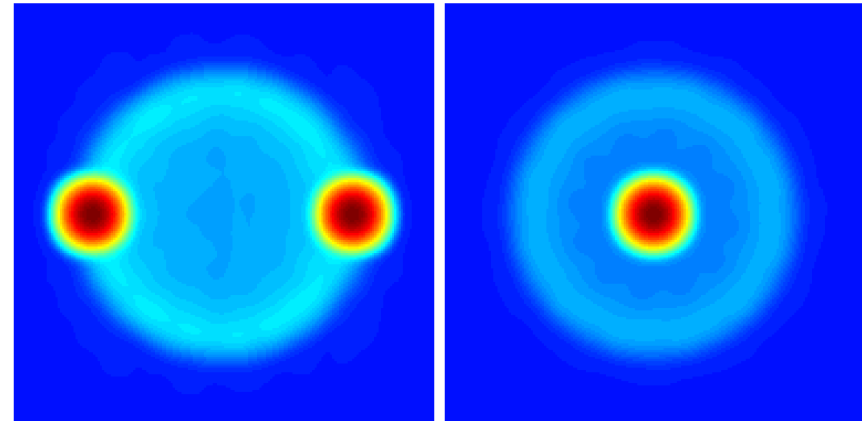
Fig. 4 The mass distribution for a SIDM galaxy cluster collision in an “ideal” scenario, where the colliding clusters are very fast and com- pact. The left panel shows the projected mass density map illustrating the scattered DM shell observed along a direction perpendicular to the collision’s axis. The right panel shows the same mass density observed along the collision’s axis. In the former, the DM shell appears as a weak